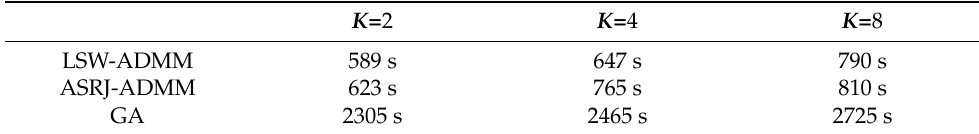
Table 6. Comparison of optimization time between MSSD-ADMM and